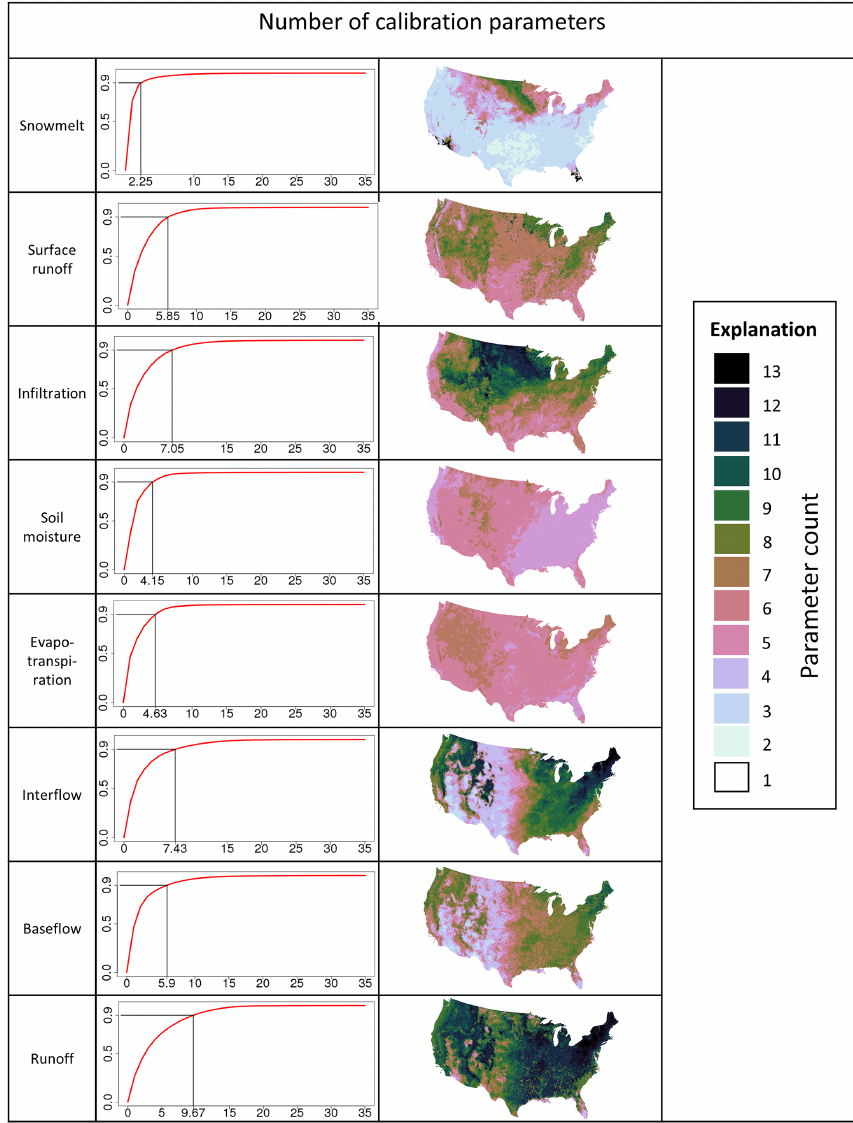
Figure 3. Cumulative parameter sensitivity across all Hydrologic Response Units (HRUs) in the CONUS Precipitation–Runoff Modeling System application are shown by process. (a) – (h) show the parameter count necessary to account for 90% of the cumulative parameter sensitivity, summarized across all HRUs. For this count, the parameters are ranked and summed until the 90% level is reached. The maps (i) – (p) show the count of ranked parameters required to reach the 90% level on an HRU-by-HRU basis, by